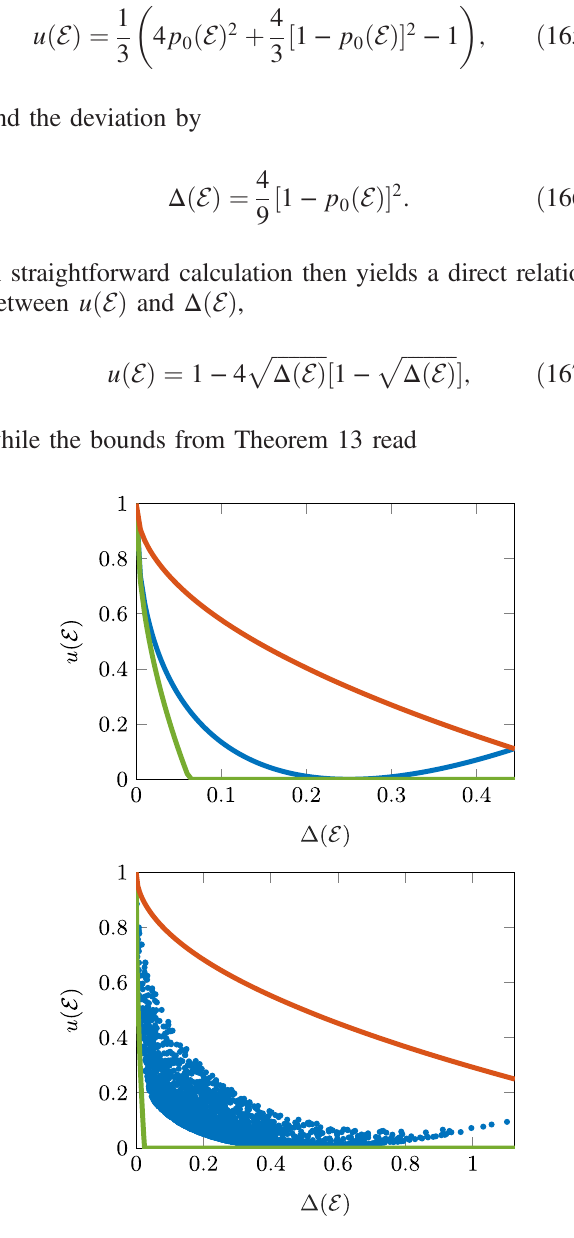
FIG. 4. Trade-off between the deviation from angular momen- tum conservation Δ ð E Þ and unitarity u ð E Þ for SU(2)-irreducibly- ffiffiffiffiffiffiffiffiffiffi p Δ ð E Þ covariant channels. The middle blue line in the top panel (spin- ; ð 164 Þ 1 = 2 system) and the blue dots in the bottom panel (spin-1 system) represent ½ Δ ð E Þ ; u ð E Þ(cid:2) pairs realized by covariant channels. The top red and bottom green curves give the upper and lower bounds specialized to the case of SU(2)